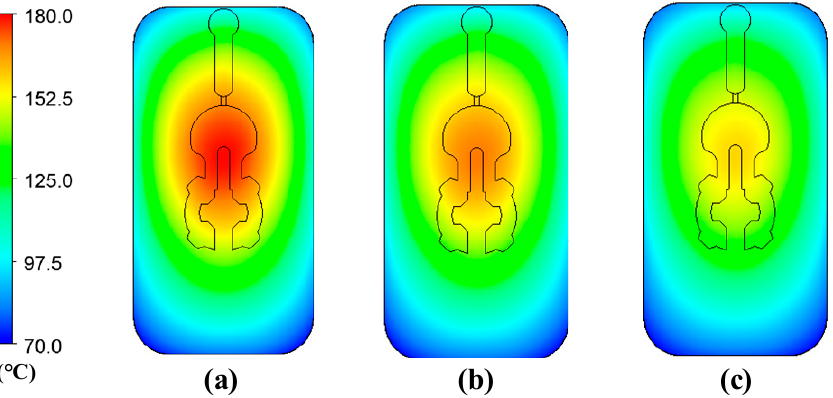
Figure 11. Temperature distribution of the molding area with an initial temperature of 30 °C; a gas temperature of 300 °C; a heating time of 20 s; and a gas gap length of ( a ) 3.5 mm, ( b ) 4.0 mm, and ( c ) 4.5 mm.